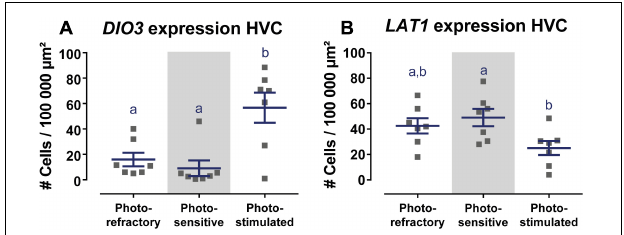
FIGURE 2 | Overview of DIO3 (A) and LAT1 (B) expression in the HVC in the photorefractory, photosensitive and photostimulated phase. Dots represent the average number of DIO3 + and LAT1 + cells per individual bird. Horizontal bars represent the average with standard error of the mean error bars ( n = 7). The gray area indicates the photosensitive phase. Different letters denote significant differences by comparison with each other in post-hoc t -tests with p < 0.05 (multiple comparison correction with Dunn’s post-hoc tests for DIO3 and Bonferroni correction for LAT1). If two time points share a common letter, DIO3 or LAT1 expression are not significantly different from each